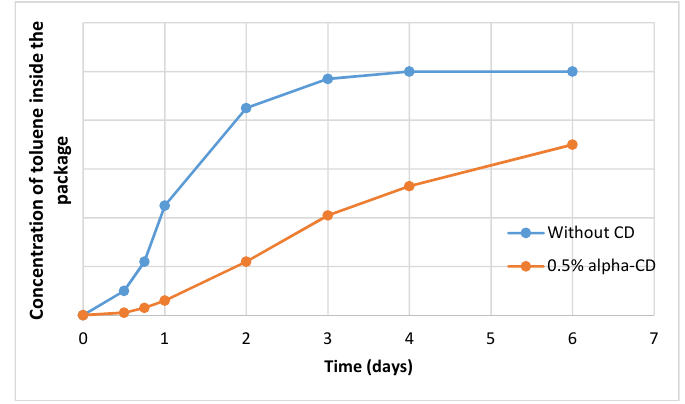
Figure 3. Permeation profile of a model pollutant through a common, or through a cyclodextrin‐containing packaging (based on data from [110]).